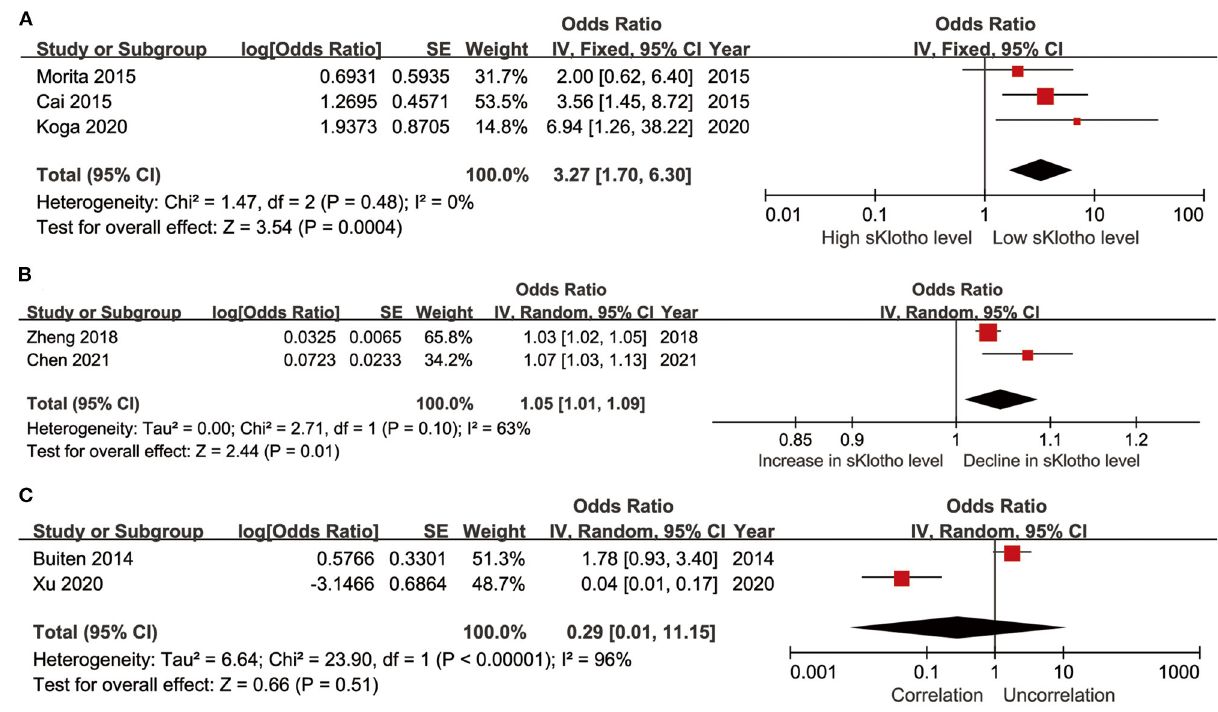
Frontiers in Physiology |